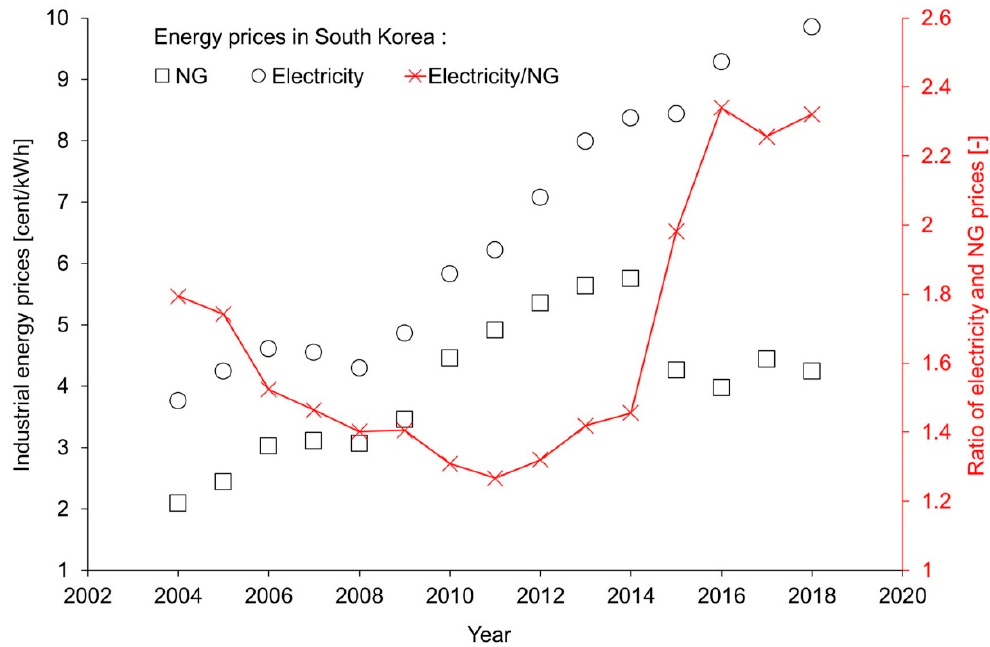
Figure 1. Variation of the prices of industrial NG and electricity and their ratios from 2004 to 2018 in South Korea [11,12].